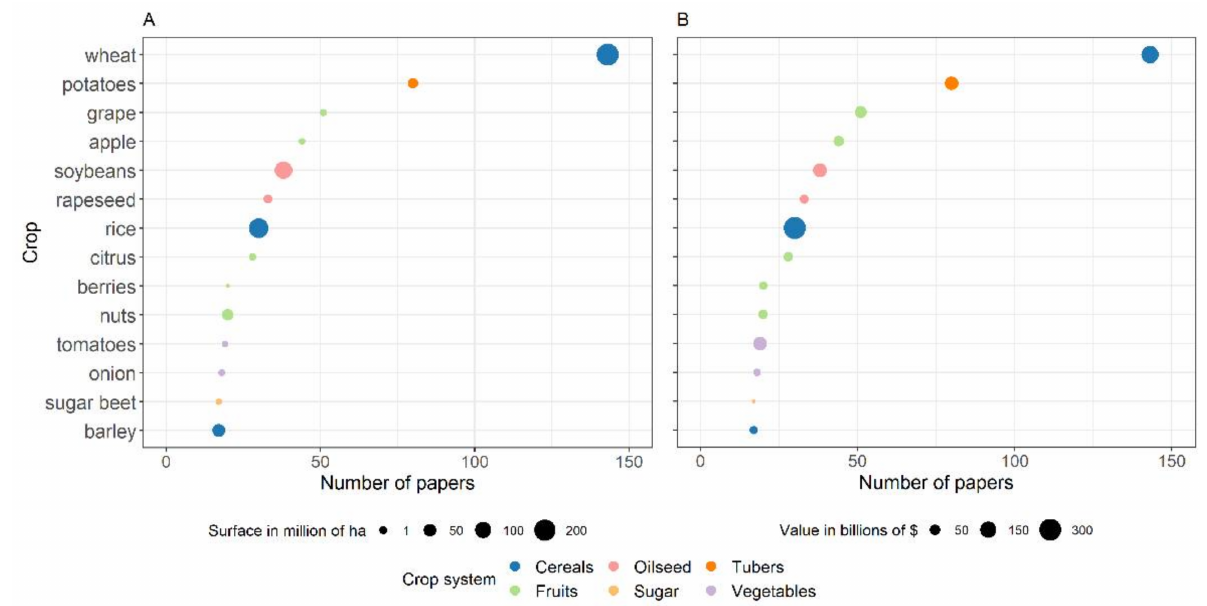
Figure 5. Crops for which > 15 papers concerning disease models have been published. The dot size indicates the global cultivated area ( A ), and the produce value in $ ( B ); the dot color defines the crop